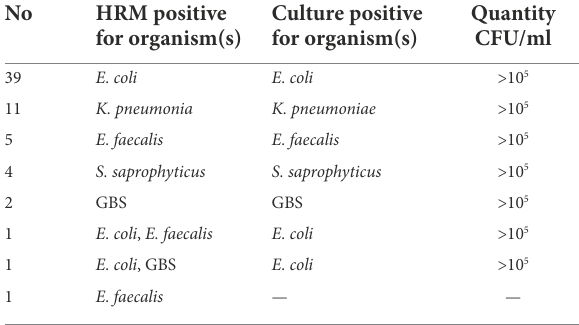
TABLE 2 Comparative analysis of HRM and culture